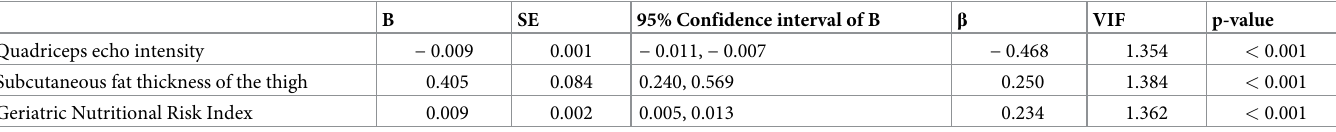
Table 5. Multiple regression analysis for muscle thickness in female model with stepwise method (n =